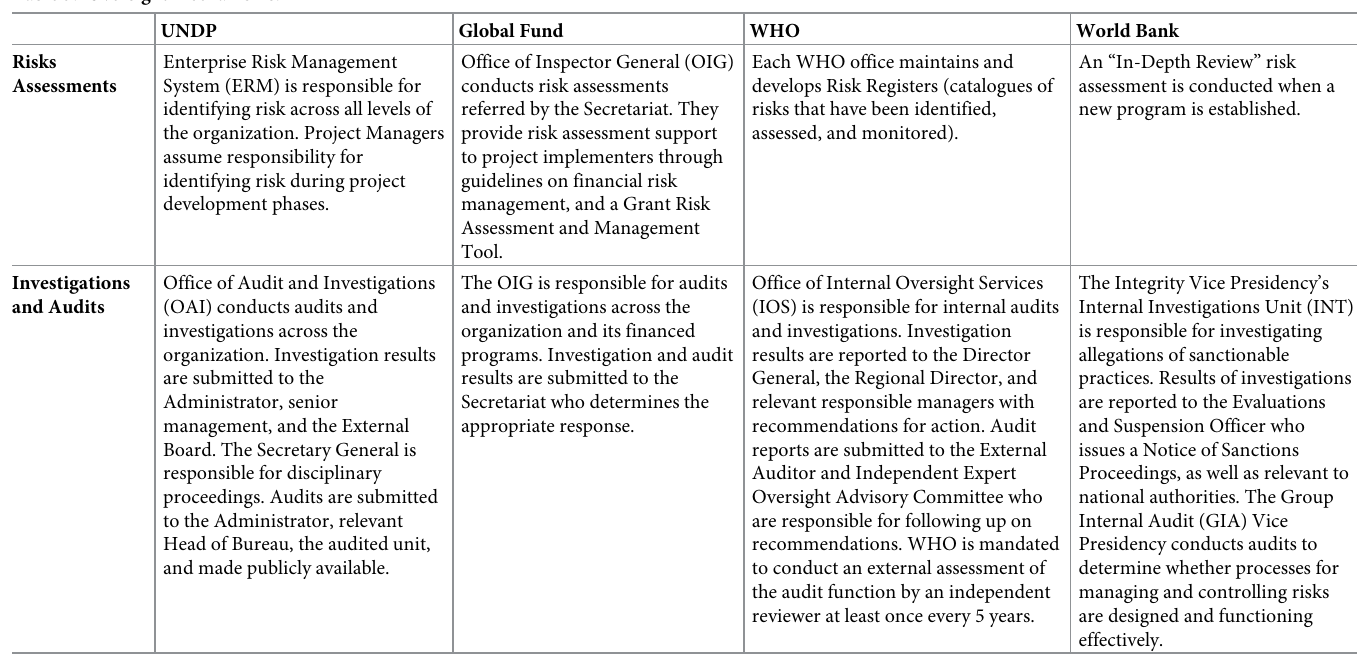
Table 5. Oversight